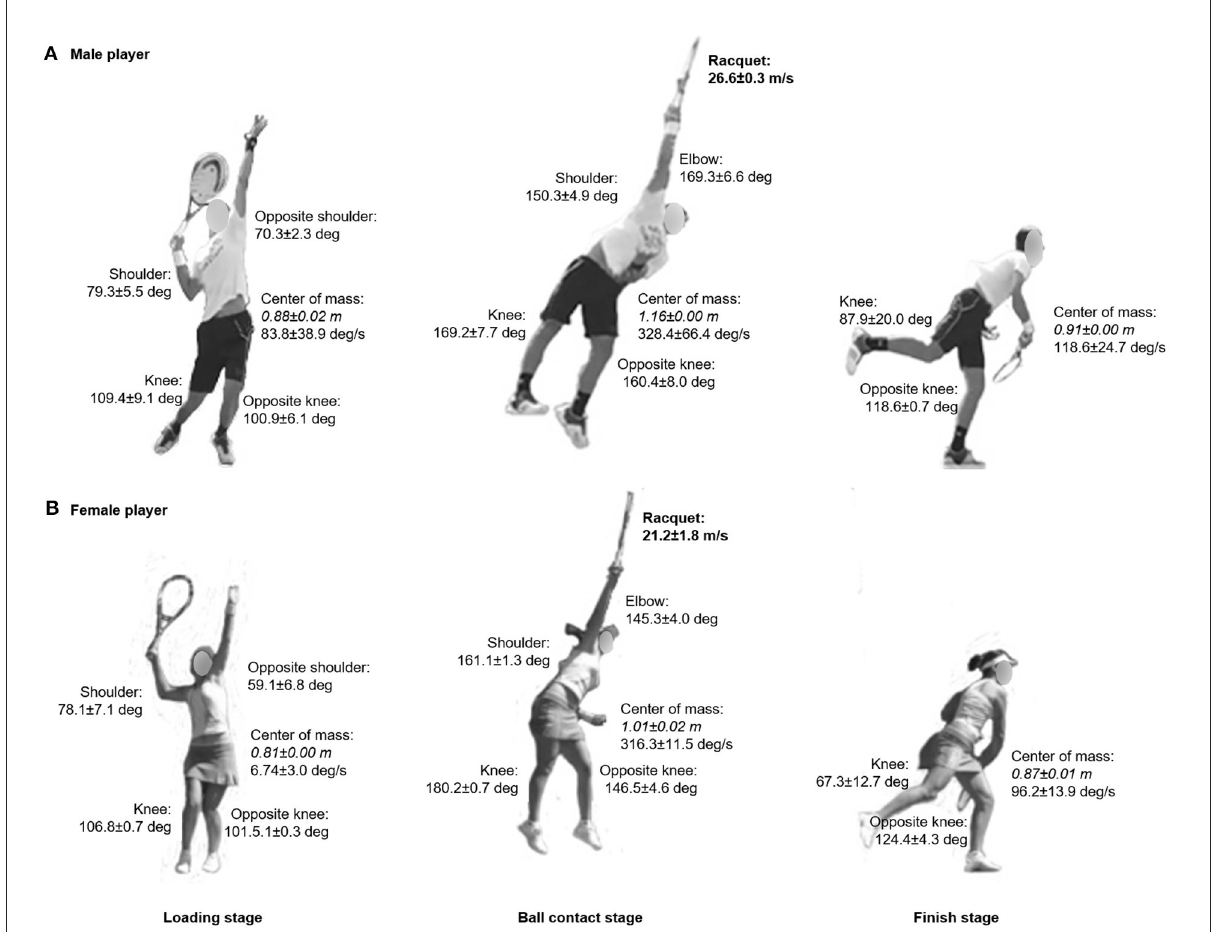
FIGURE1 Joint angles, center of mass displacement (in italic) and rotation during loading, ball contact and finish stages of the serve for the male [upper panel, (A) ] and female tennis players [lower panel, (B) ]. Racquet velocity (in bold) is also displayed at ball contact stage. Values are means ± SD from trials 1 and